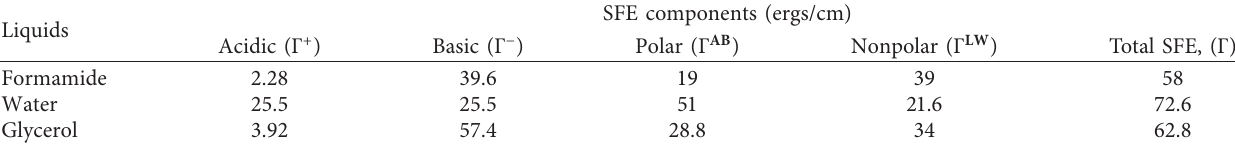
Table 4: SFE components of materials in order to calculate the same components for bitumens.